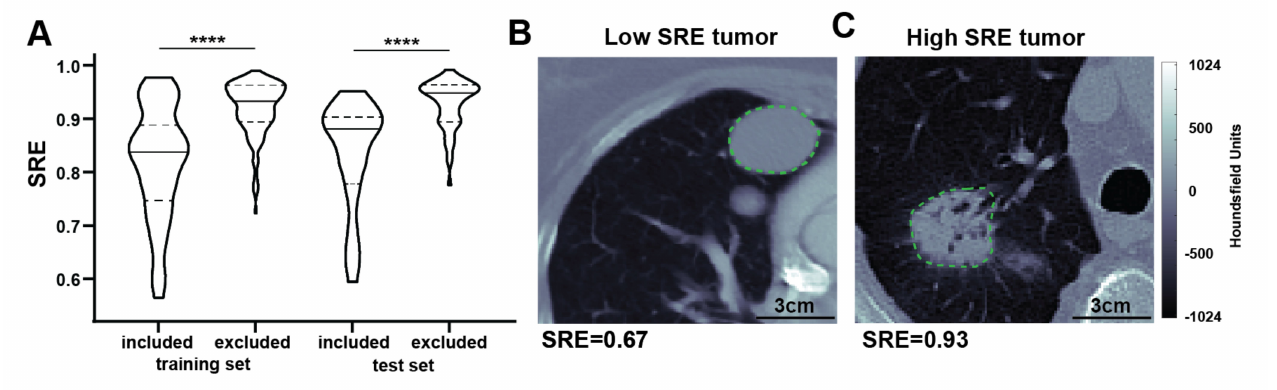
Figure 4. Differences in radiomic features can be apparent visually. The model for selection of patients likely to benefit from Evofosfamide treatment favored low Short Run Emphasis (SRE) ra- diomic feature for proposed inclusion into the trial. As shown in the violin plot ( A ), significantly lower SRE is observed in the included vs. excluded patient groups both in training and test cohorts. Qualitatively, a representative tumor with low Short Run Emphasis SRE ( B ) appears more regular and homogeneous in a contrast enhanced CT scan than a corresponding tumor with similar volume (15.0 vs. 16.5 mL respectively), and relatively high SRE ( C ), which shows higher intratumor hetero- geneity. In the violin plot a solid line indicates median while dotted lines indicate 25th and 75th percentile. **** p <